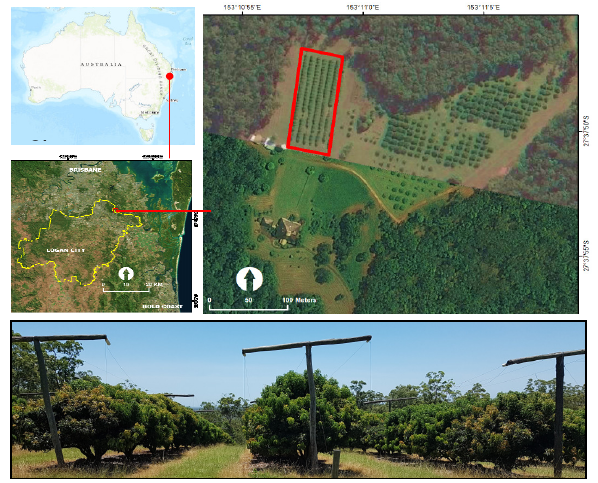
Figure 1. Study area location and field photo of the lychee trees.